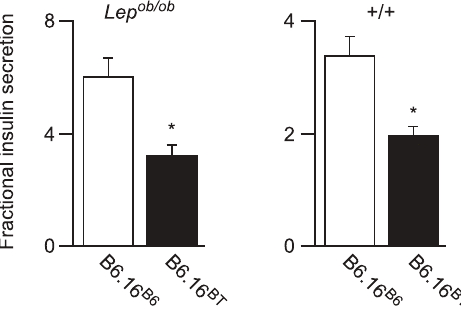
Figure 2. Effect of substitution of BTBR chromosome 16 in the B6 Lep ob/ob mice on insulin secretion. Islets were isolated from Lep ob/ob (left graph) and lean (right graph) 10-week B6.16 B6 and B6.16 BT male mice. Lep ob/ob islets were incubated with 16.7 mM glucose and the islets from the lean mice were incubated with 3 mM 8-bromo cAMP at 11.1 mM sub-maximal glucose. Values are mean 6 S.E. of N $ 3. * p # 0.05 for fractional insulin secretion from islets of B6.16 BT mice vs. control B6.16 B6 mice.